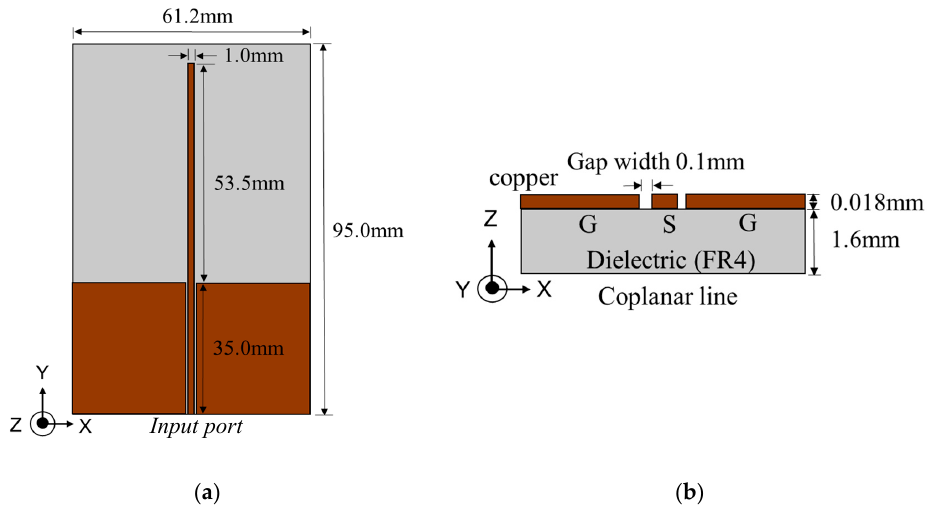
Figure 10. Layout of the proposed antenna. ( a ) layout , ( b ) cross sectional view.